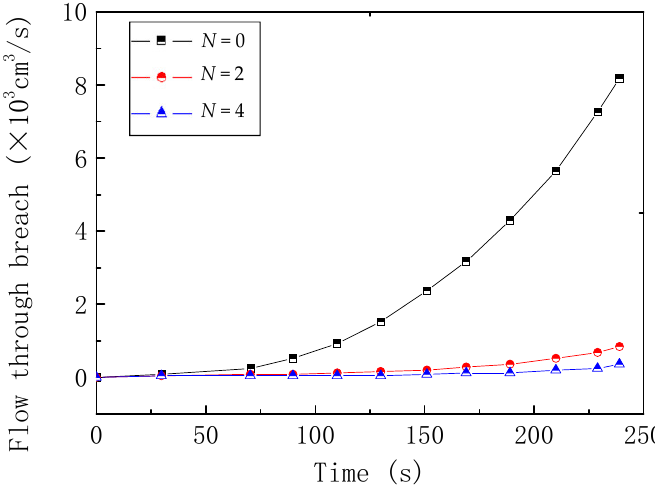
Figure 13. Calculated of flow through breach with different reinforcement layers.